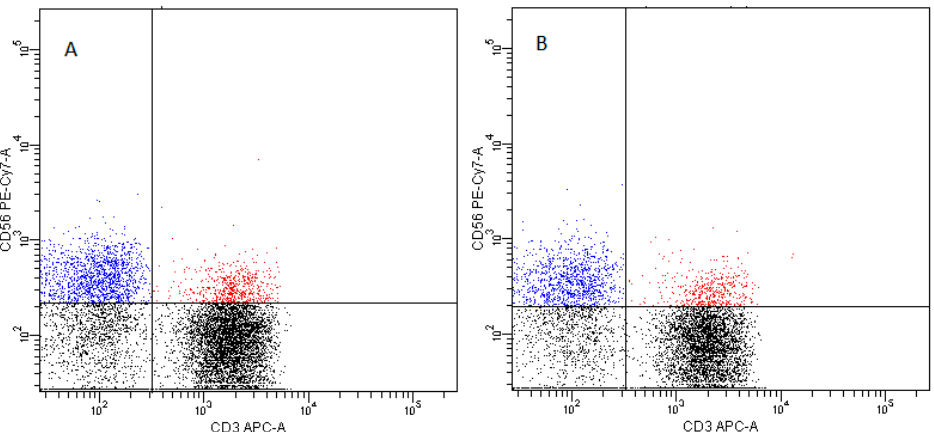
Figure 16. Exemplary plots of flow cytometry analysis showing the staining with antibodies specific for CD3 and CD56 in lymphocyte fraction: ( A ) peripheral blood ( B ) FNAB. Blue dots—CD3 − CD56 + NK cells, red dots—CD3 + CD56 + NKT cells.